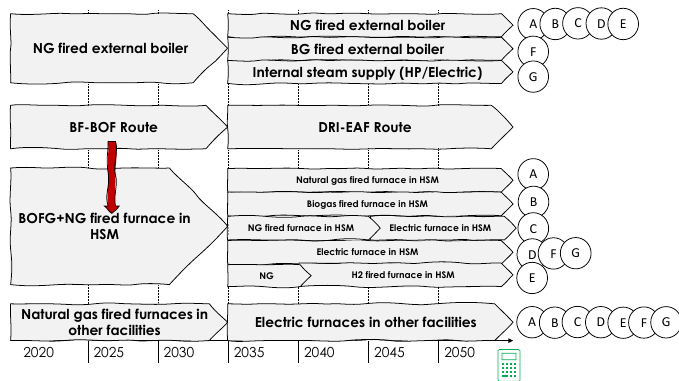
Figure 3. Energy supply storylines